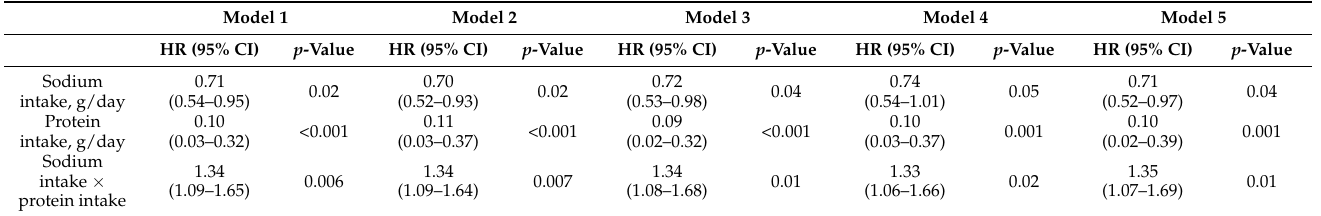
Table 3. Associations between sodium intake, protein intake, and their interaction term with all-cause mortality.